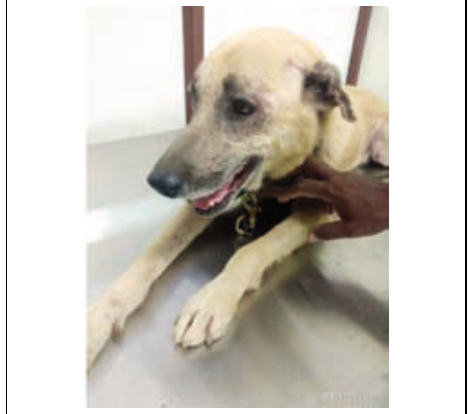
Fig. 2. Adhesive tape impression showing yeast cells on